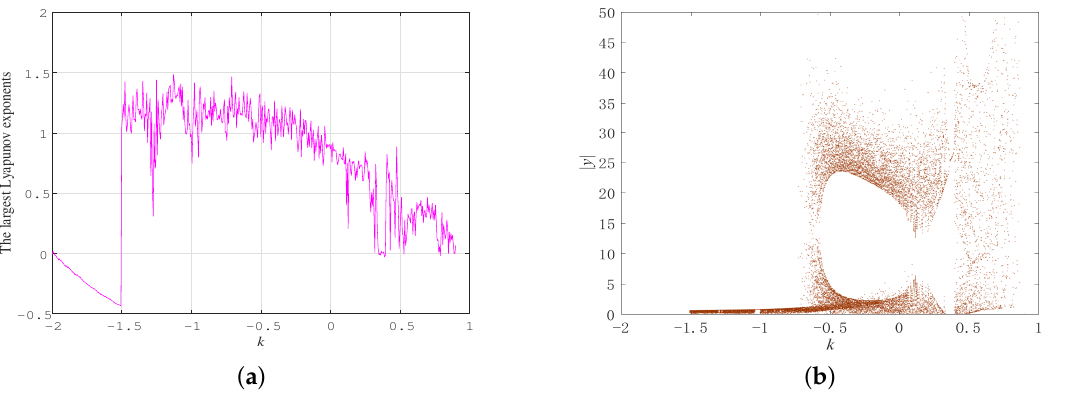
Figure 11. Largest Lyapunov exponent spectrum ( a ) and bifurcation diagram ( b ) of system (1) versus k , where a = 10, b = 100, c = 11.2.